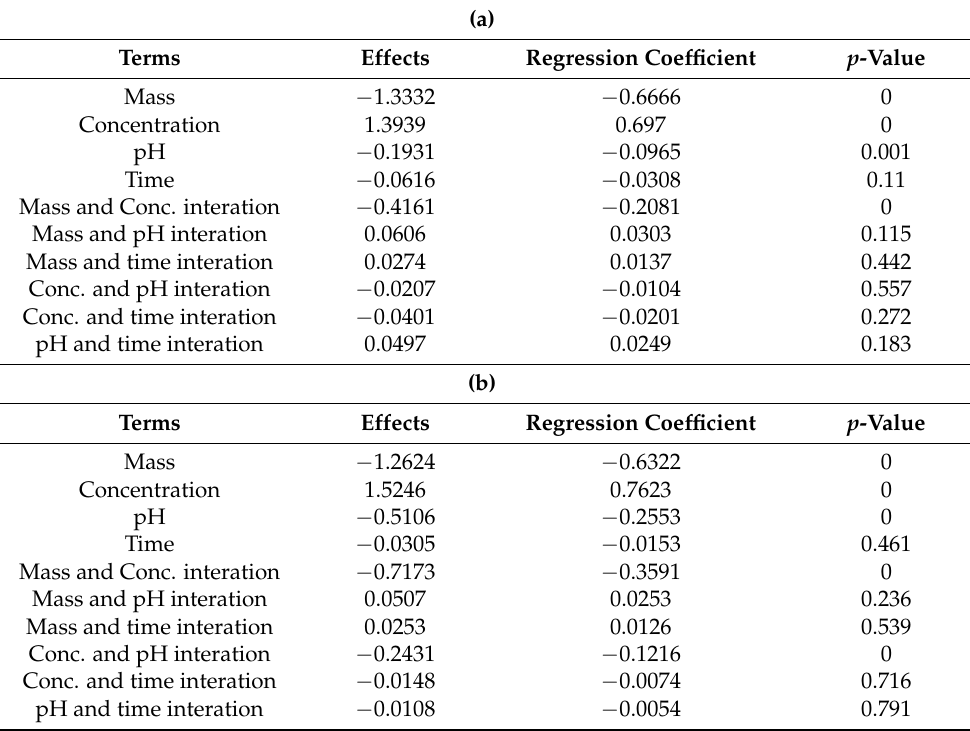
Table 7. Quantification of effects of the independent variables on the response variable Q t of the factorial design of palygorskite clay. ( a ) Acid and ( b ) organo-functionalized